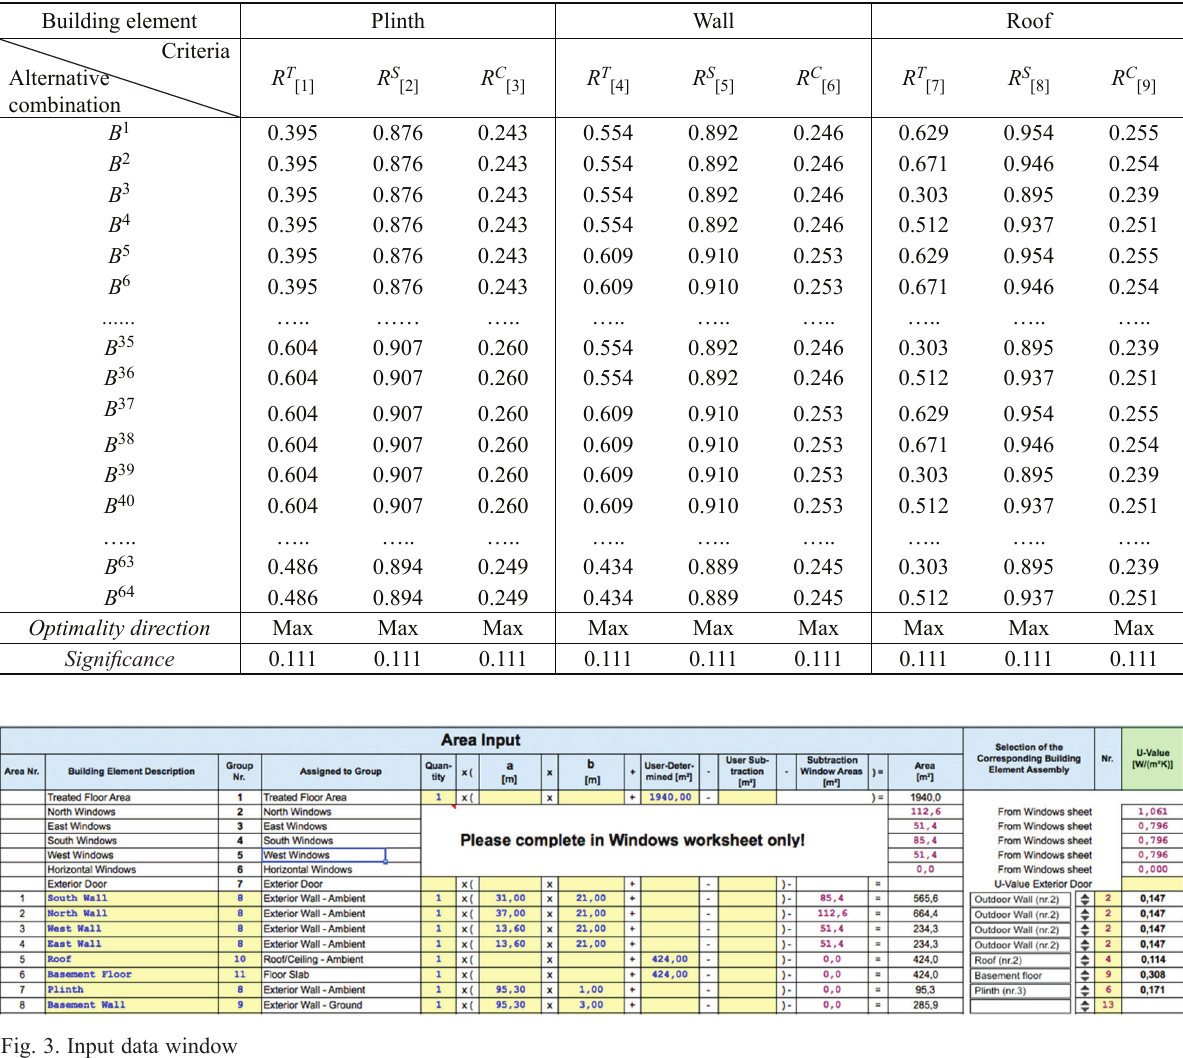
table 5. Fragment of the alternative combinations of modernization measures Building element Plinth Wall Roof criteria